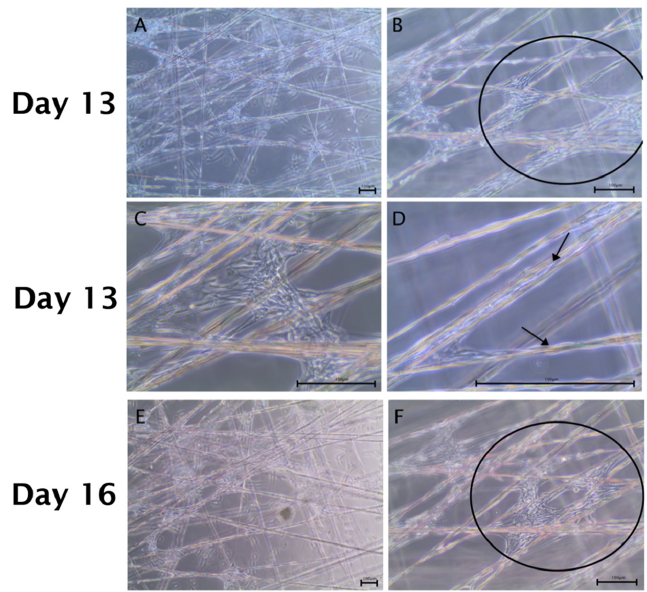
Figure 4. ADSCs and Schwann cells in co-culture on a spider silk scaffold from day 13 to day 16. Scale bars in ( A – F ) represent 100 µm. Bright field images illustrate co-cultures in low ( A , C , E ) and high ( B , D , F ) magnifications, respectively. ( A – D ) By day 13, cells had distributed equally along the silk fibers and confluent cell layers were observed at fibers crossing (indicated by the black circle in B ); ( D ) cells migrating along the silk showing long shaped morphology (indicated by black arrows in D ). ( E , F ) After day 16, an almost confluent layer of cells was formed over the mesh (shown in the black circle in F ). After 21 days in culture, the construct of spider silk and cells was embedded in paraffin using HistoGelTM. Paraffin slides were cut and mounted onto microscope slides for analysis. Slides were either stained using the Hematoxylin & Eosin method (Figure 5) or used for immunohistochemistry